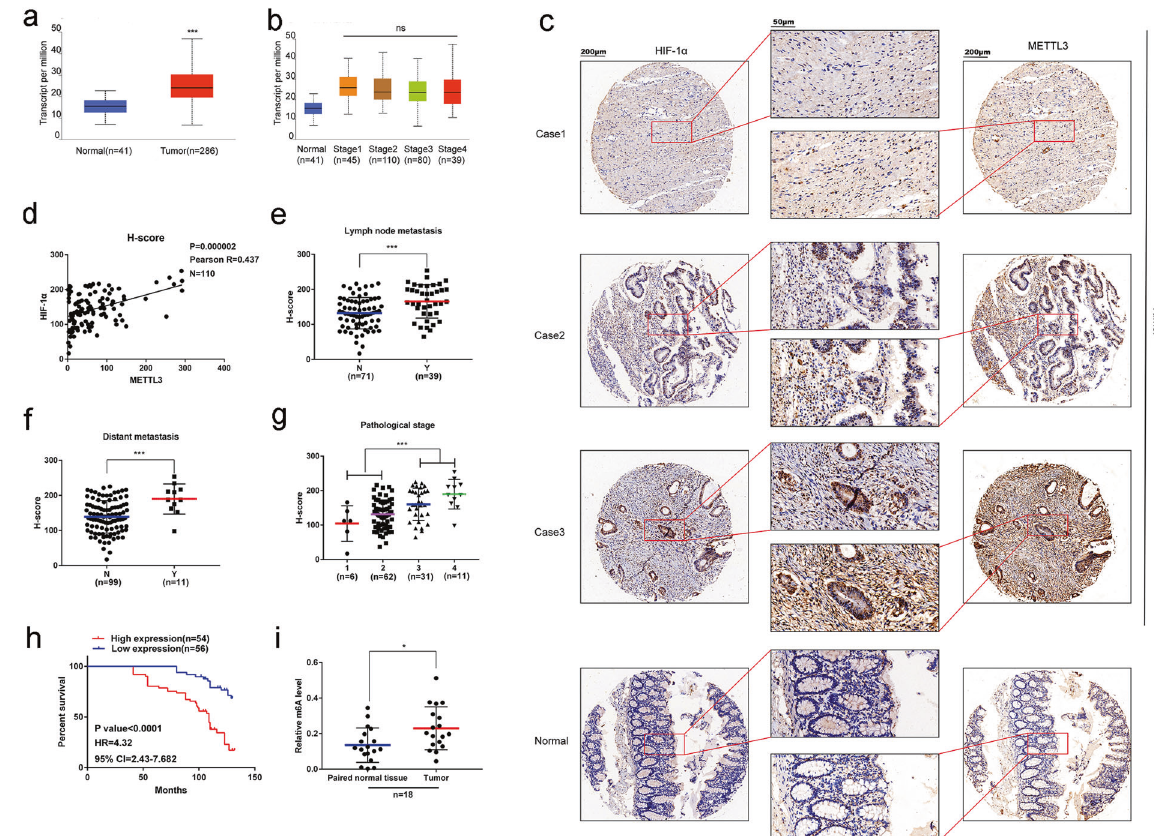
Fig. 1 METTL3 and HIF-1 α are co-expressed in colorectal cancer (CRC) accompanied with upregulated m6A modi fi cation. a The mRNA expression of METTL3 in TCGA-COAD databases. b Total m6A modi fi cation level in clinical CRC specimens and paired no-tumor bowel tissues ( n = 18). c mRNA expression of METTL3 in each pathological stage of patients in TCGA-COAD databases. d Association of METTL3 and lymph node metastasis (N = no lymph node metastasis, n = 71; Y = lymph node metastasis, n = 39). e Association of METTL3 and distant metastasis (N = no distant metastasis, n = 99; Y = distant metastasis, n = 11). f Association of METTL3 and pathological stage (early stage: stage I and II, n = 68 vs. advanced stage: stages III and IV, n = 42). g Kaplan – Meier analysis showed high expression of METTL3 indicates poor overall survival ( p < 0.0001, HR = 4.32, 95% CI = 2.43 – 7.682). (ns: no signi fi cance, * p < 0.05, *** p < 0.001). h Co-expression of METTL3 and HIF-1 α in clinical CRC specimens analyzed by Pearson correlation analysis based on H-score ( P = 0.000002, R = 0.437, n = 110). i The protein expression of